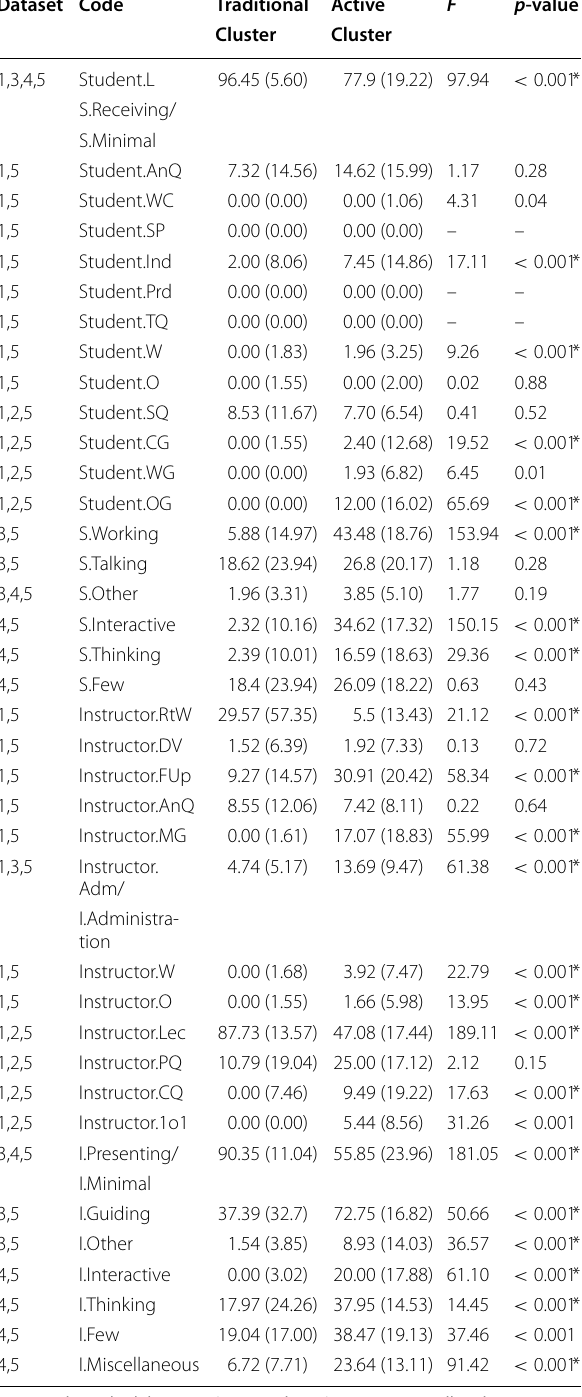
Table 5 Summary statistics of the percentage of time for each of the COPUS codes by